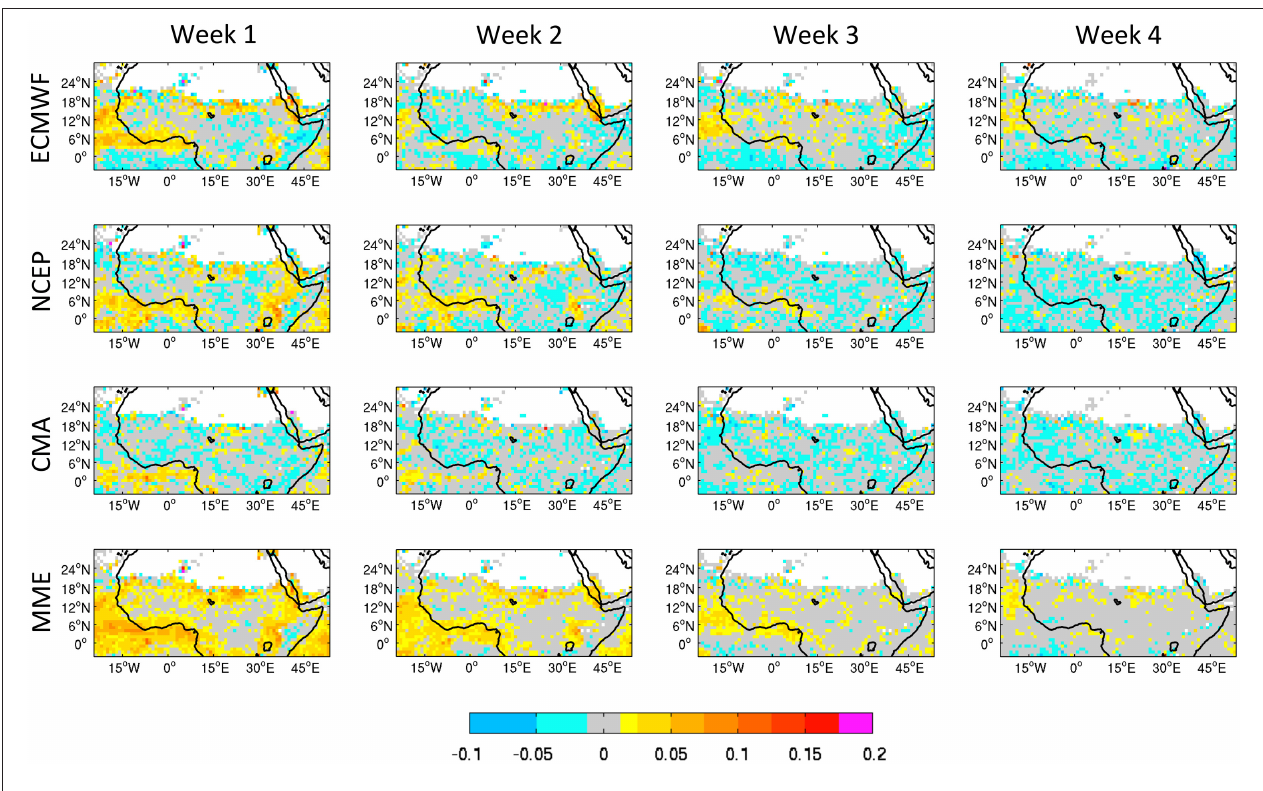
FIGURE 6 | Similar to Figure 5 but for the West African monsoon